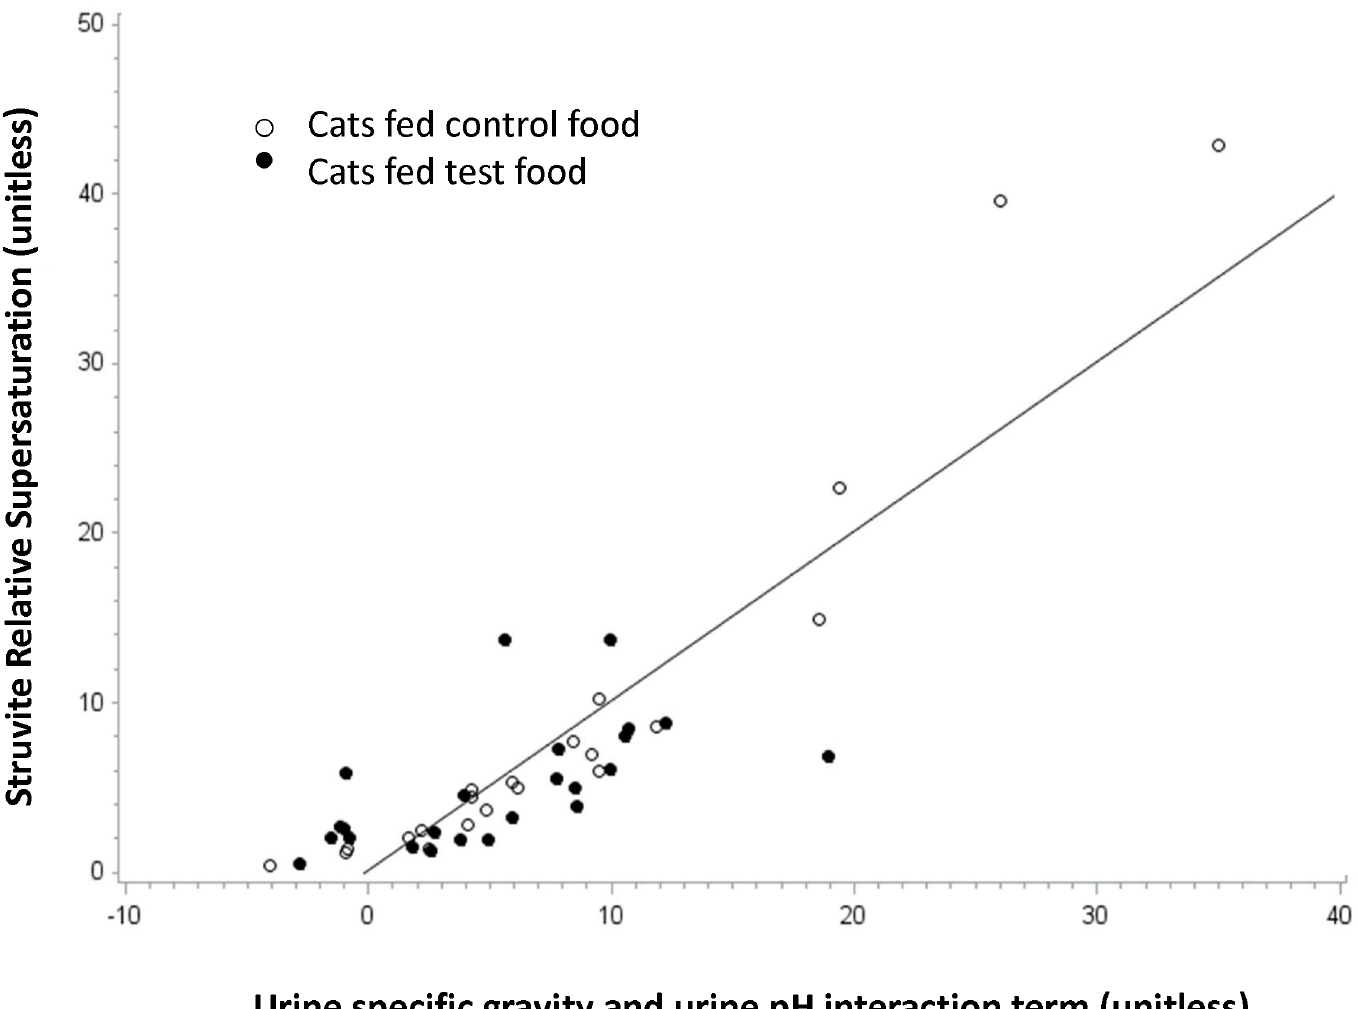
Fig 1. Struvite relative super saturation. The struvite relative super saturation (RSS; y-axis) is predicted using urine specific gravity ( P < 0.001)and urine pH ( P < 0.001) measurements (interaction P < 0.001;x-axis). Each cat ( n = 12) is representedtwice by an open circle, for 28 and 56 days on control food, and twice by a filled circle, for 28 and 56 days on test food. Feedingtest food decreased urine specific gravity and decreased urine pH, togetherboth of which decreased struvite RSS ( r 2 = 0.69; P < 0.001). Note that there are fewer cats fed test food in the upper right quadrantof the graph.